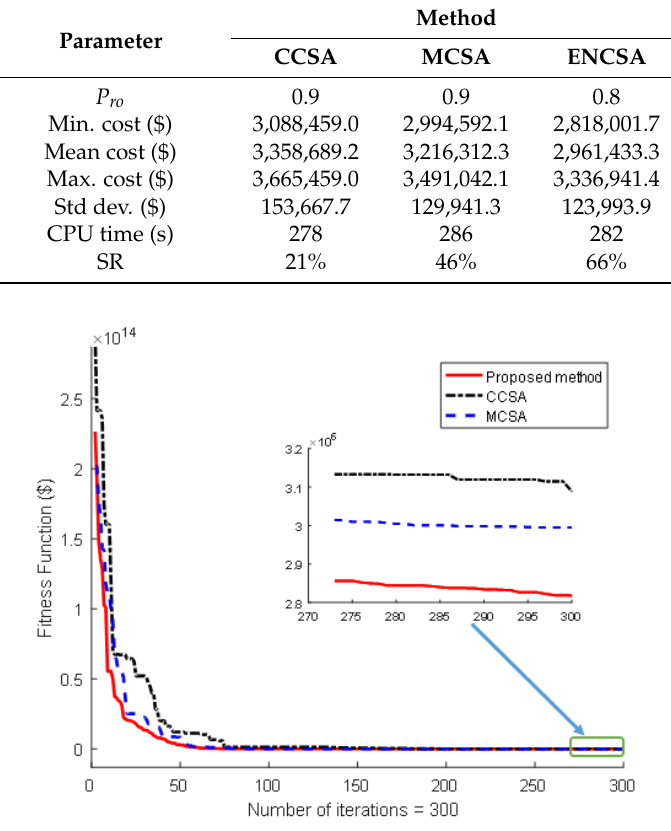
Table 5. Comparison of obtained results for the IEEE 118 buses system.